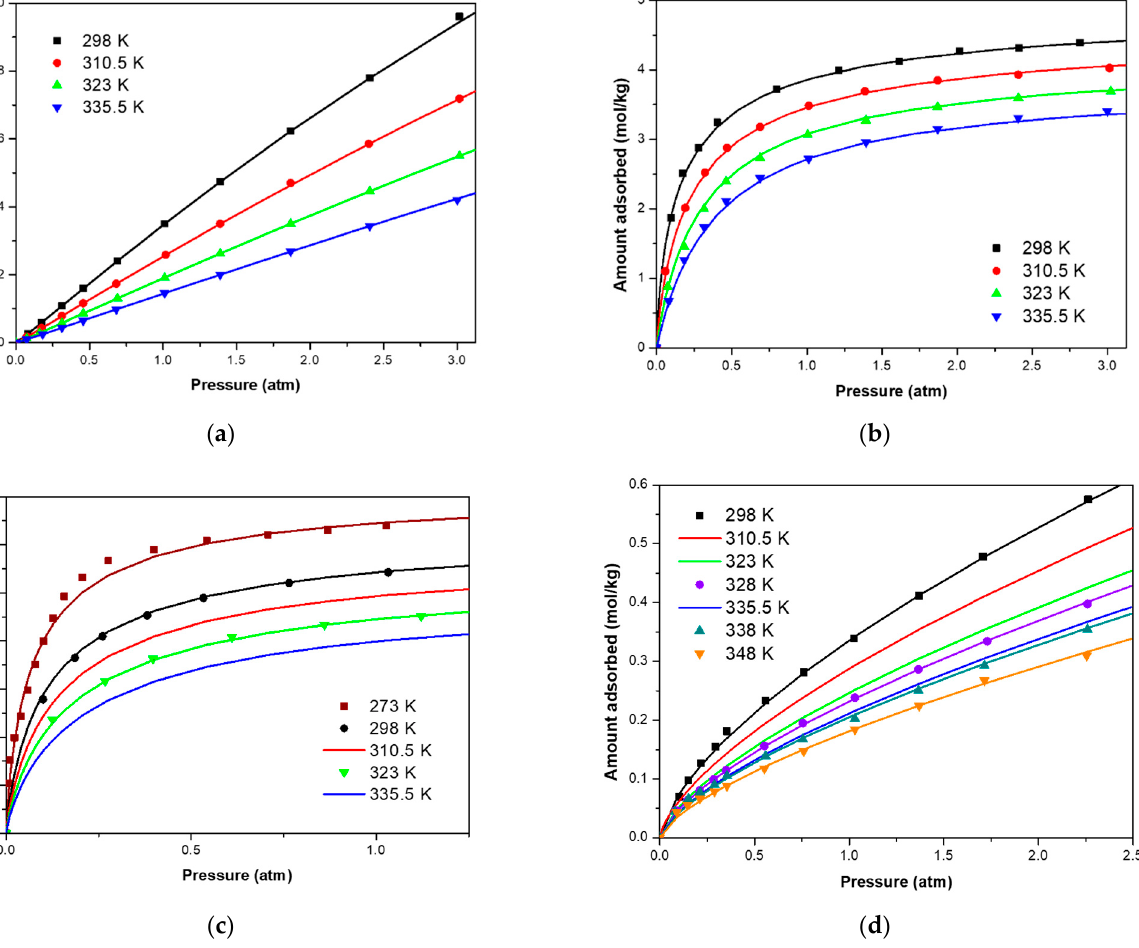
Figure 7. Adsorption isotherm fitting curve of ( a ) CO 2 , ( b ) CH 4 , ( c ) H 2 S, and ( d ) N 2 on COSMO zeolite 13X. Solid points represent the experimental data; solid lines represent the fitted equilibrium adsorption model. Table 10. Parameters in Langmuir–Freundlich isotherm for COSMO zeolite 13X.